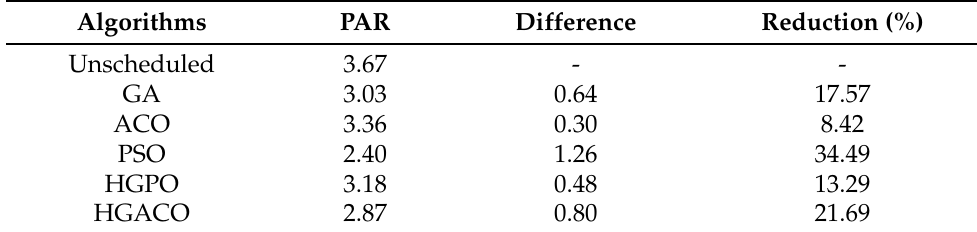
Figure 15. PAR assessment with PV. Table 10. Scenario II: PAR assessment with